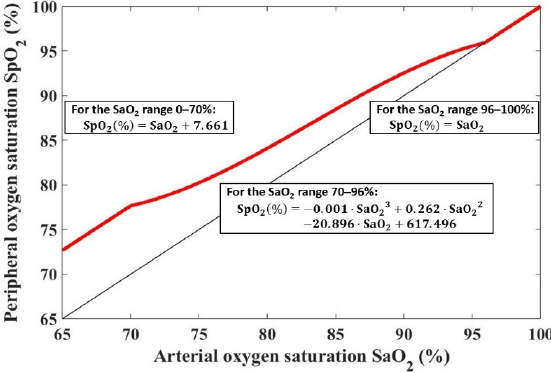
Figure 2. The SaO 2 –SpO 2 bias function is shown with a red line. The black line shows SpO 2 = SaO 2